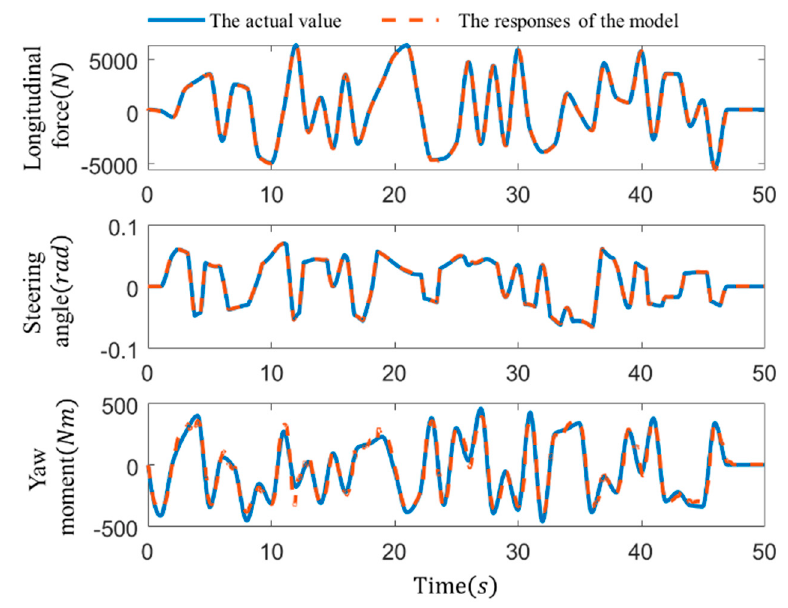
Figure 5. The responses of the back propagation neural network (BPNN) model.